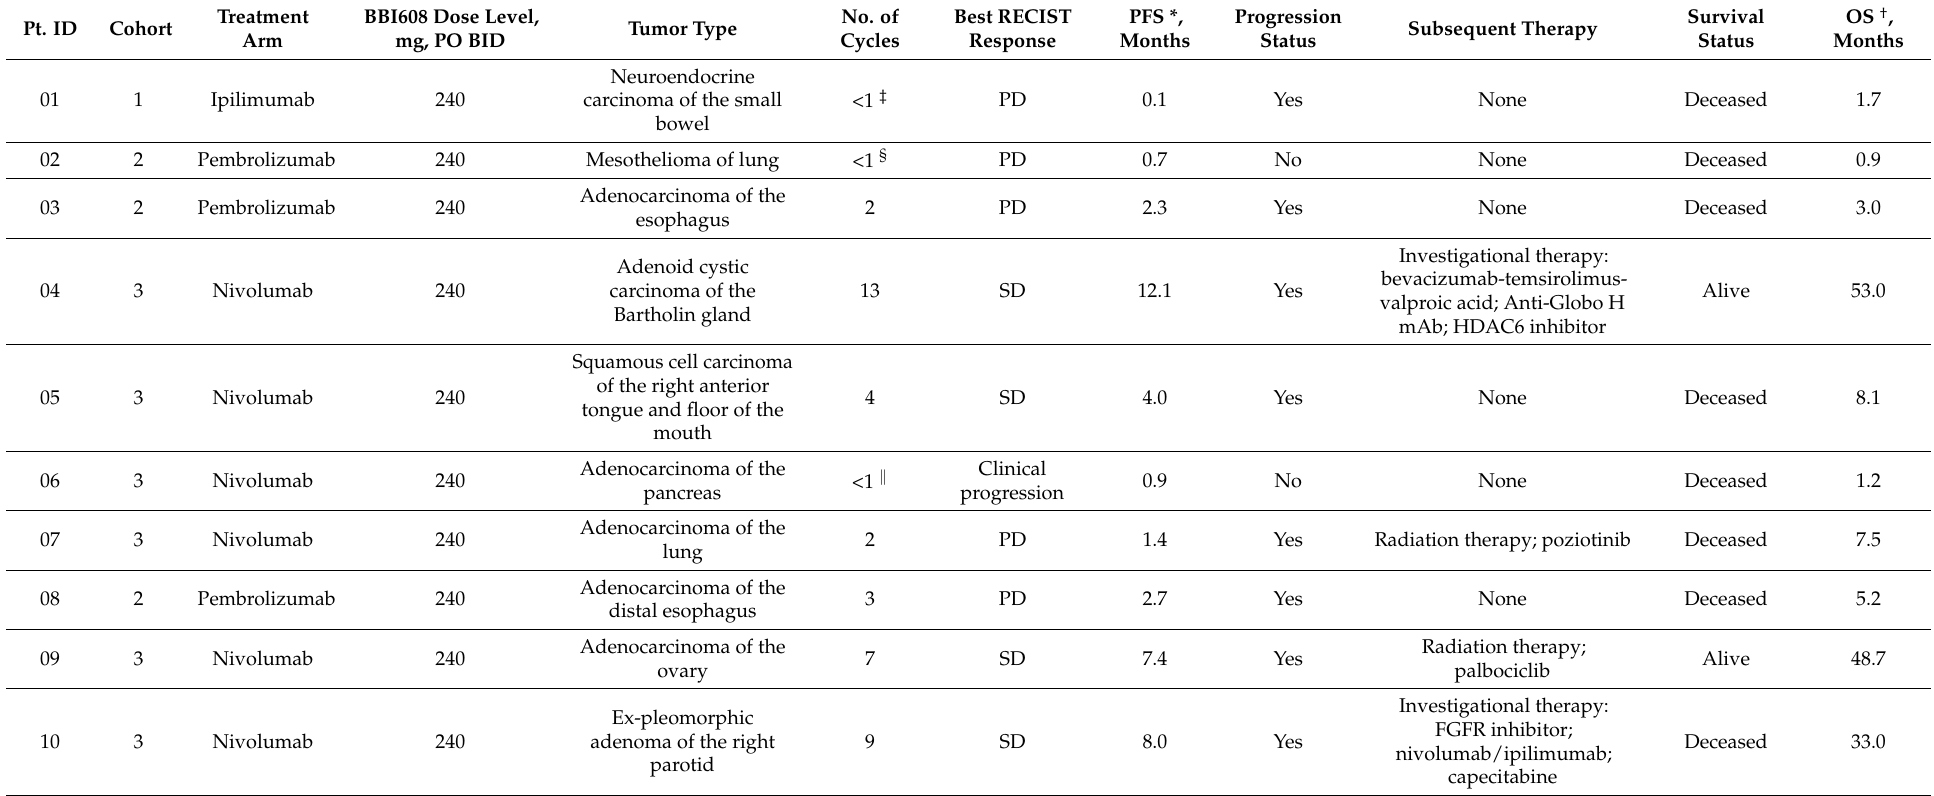
Table 4. Clinical outcomes of 12 patients who underwent treatment with BBI608 and